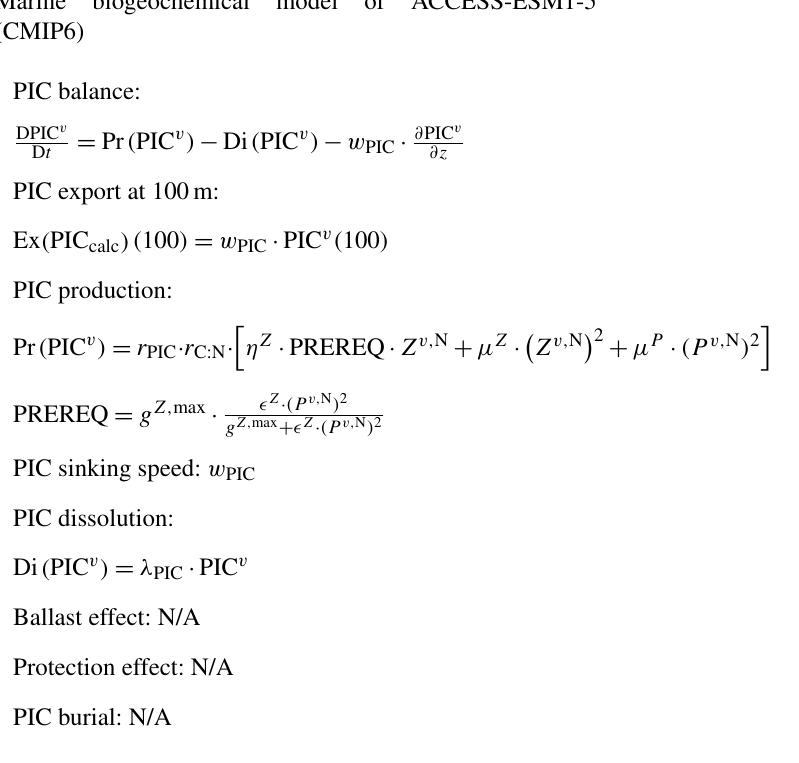
Table C7. WOMBAT parameters. Variable/parameter